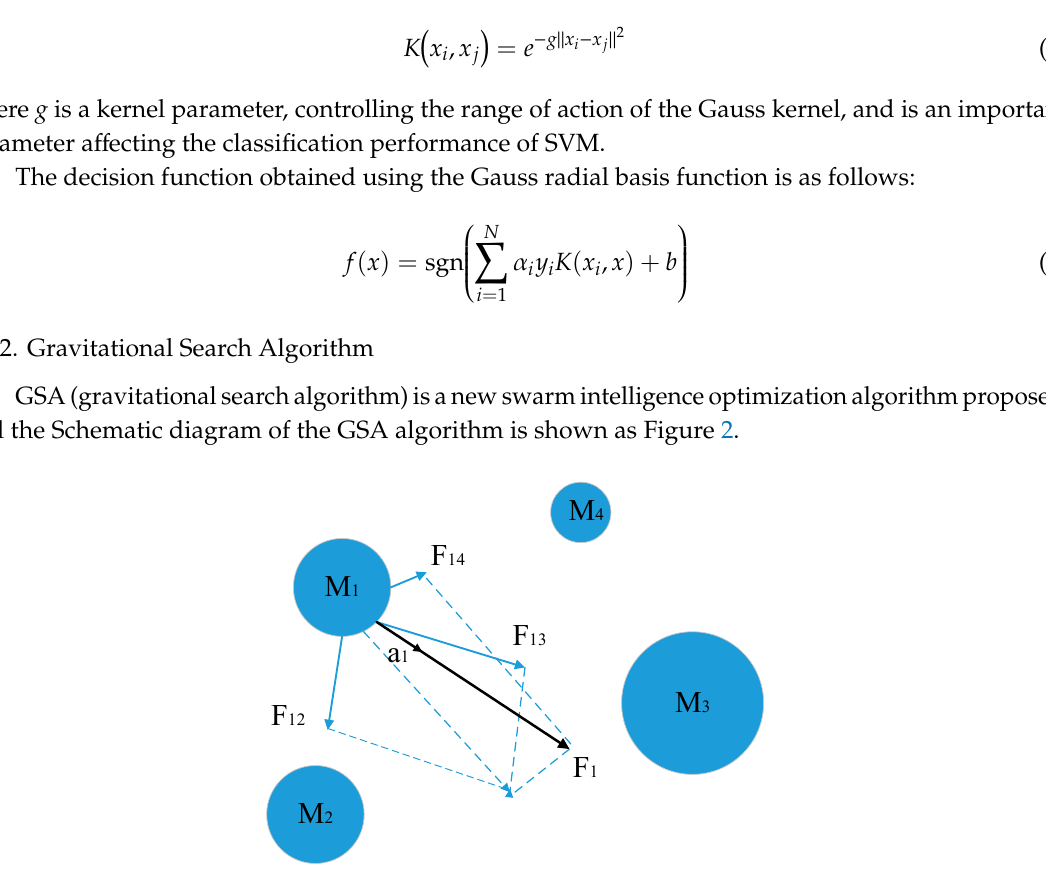
Figure 2. The schematic diagram of the gravitational search algorithm (GSA).